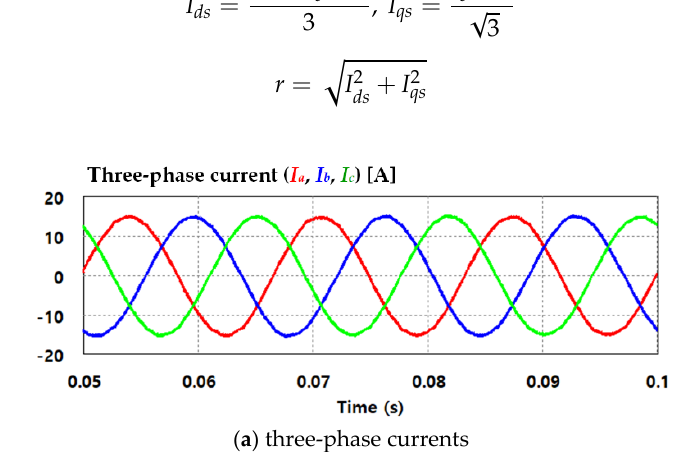
( a ) three-phase currents Figure 7. Cont